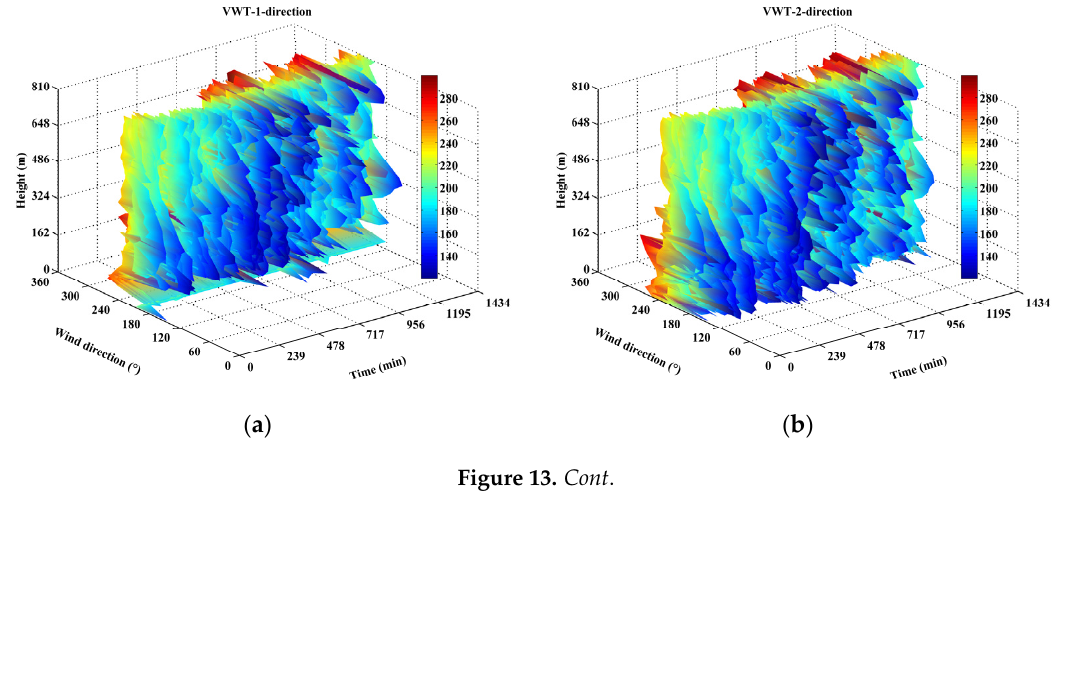
( d ) ( e ) Figure 13. Spatio-temporal distribution of wind direction, ( a ) VWT-1; ( b ) VWT-2; ( c ) VWT-3; ( d ) VWT-4; ( e ) VWT-5. Taking VWT-3 as an example, 6 specific heights were selected. Figure 14 shows the time-history change of wind direction at this position. It can be roughly seen that wind- direction fluctuation decreases with the increase in height, reflecting that the interference of a U-shaped valley to incoming flow gradually decreases with height.